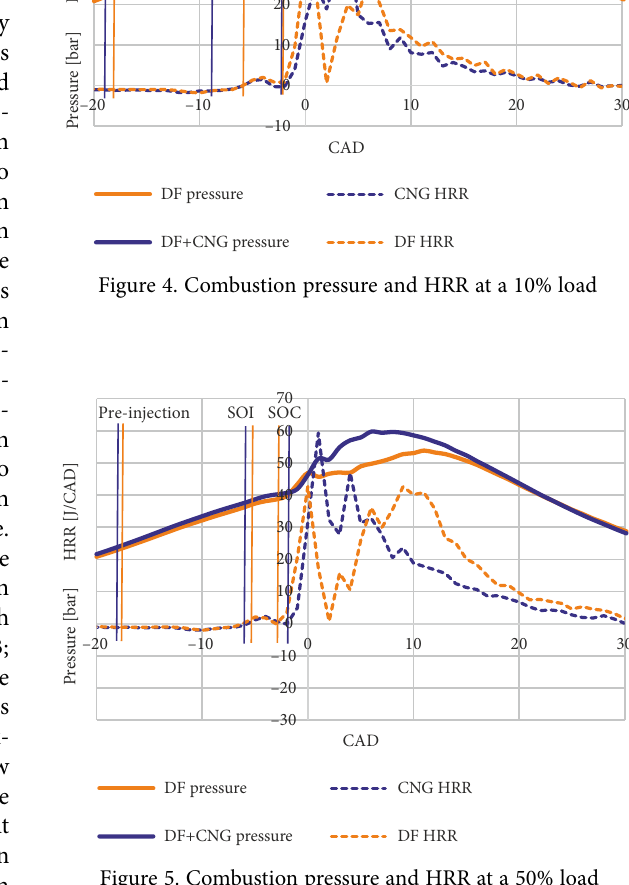
Figure 5. Combustion pressure and HRR at a 50% load